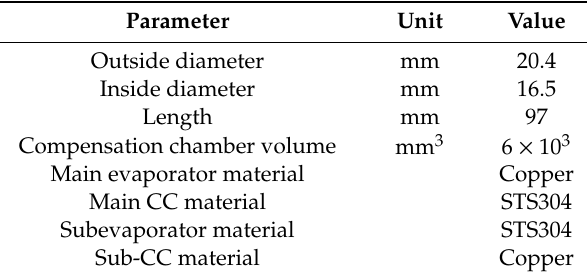
Figure 2. Structure of the evaporator. Table 2. Design specification of the evaporators.